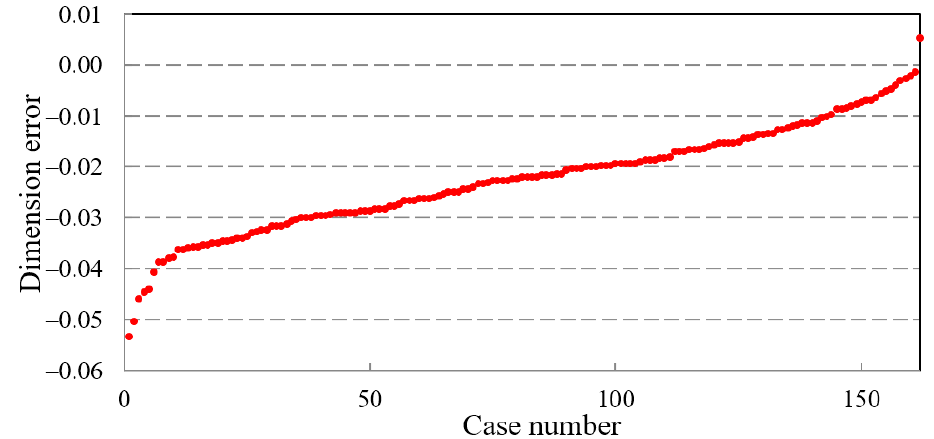
Figure 17. Dimensional accuracy distribution.